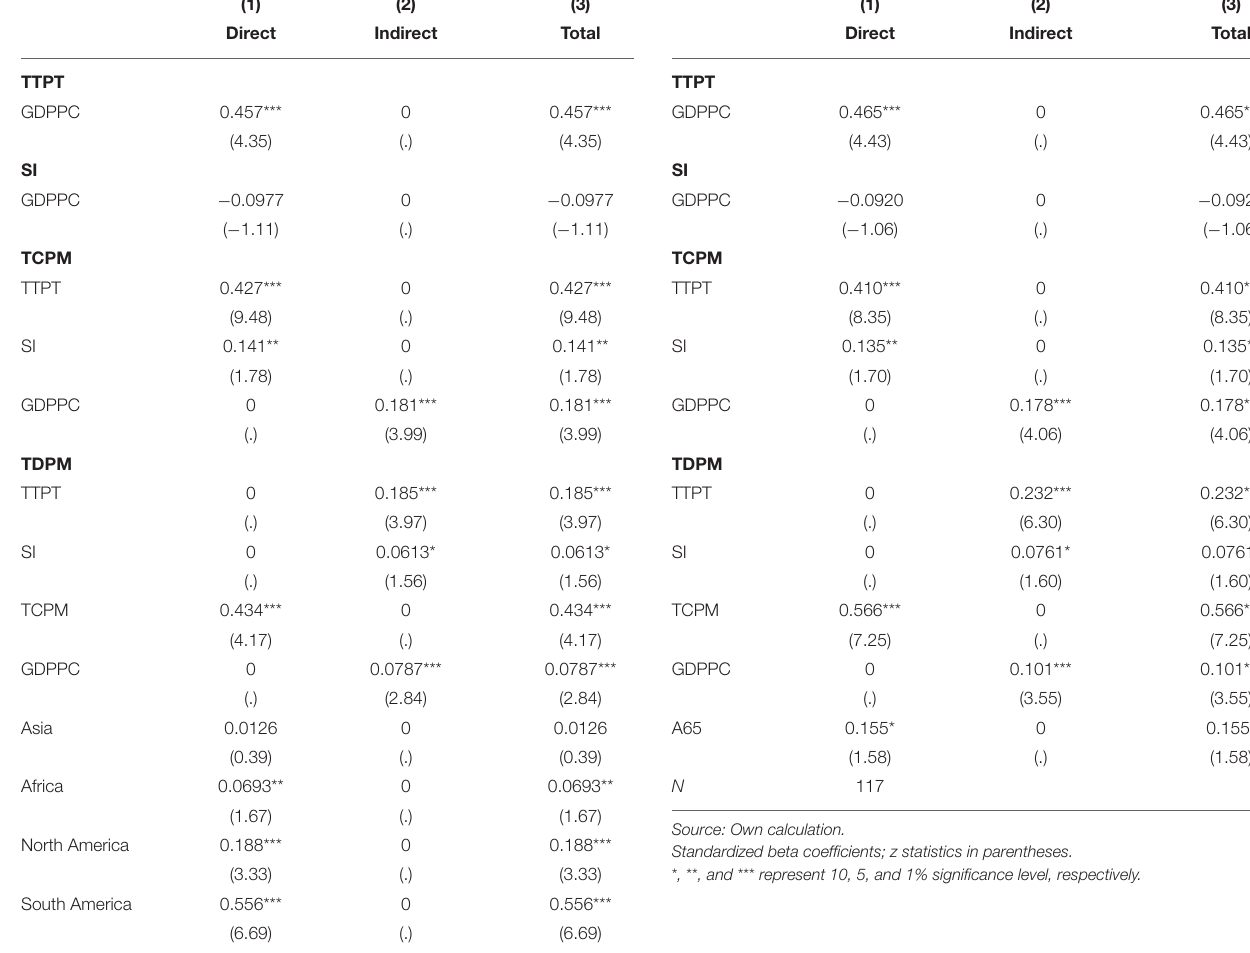
Model 1a. Estimated Base model with Regional